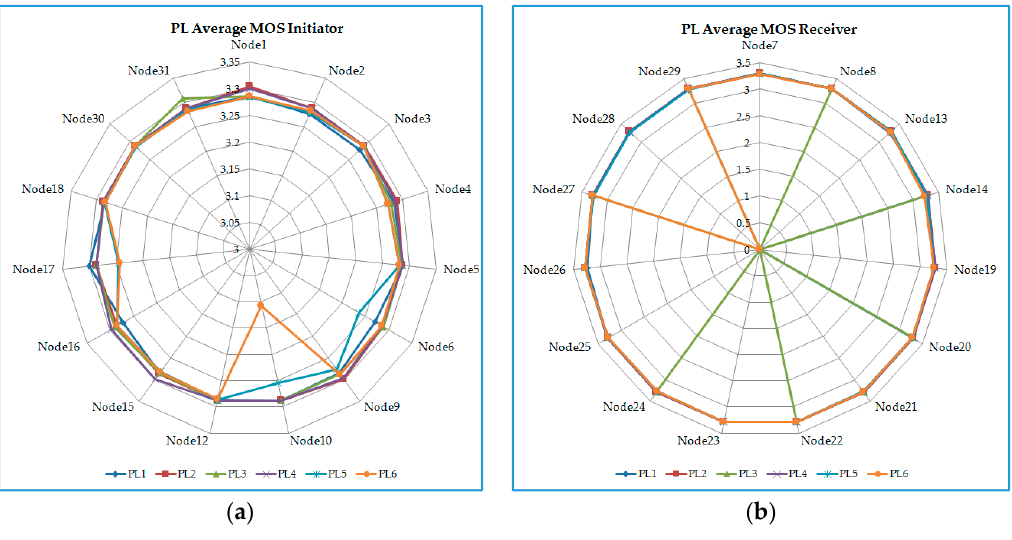
Figure 13. Platoon scenario line deployment.